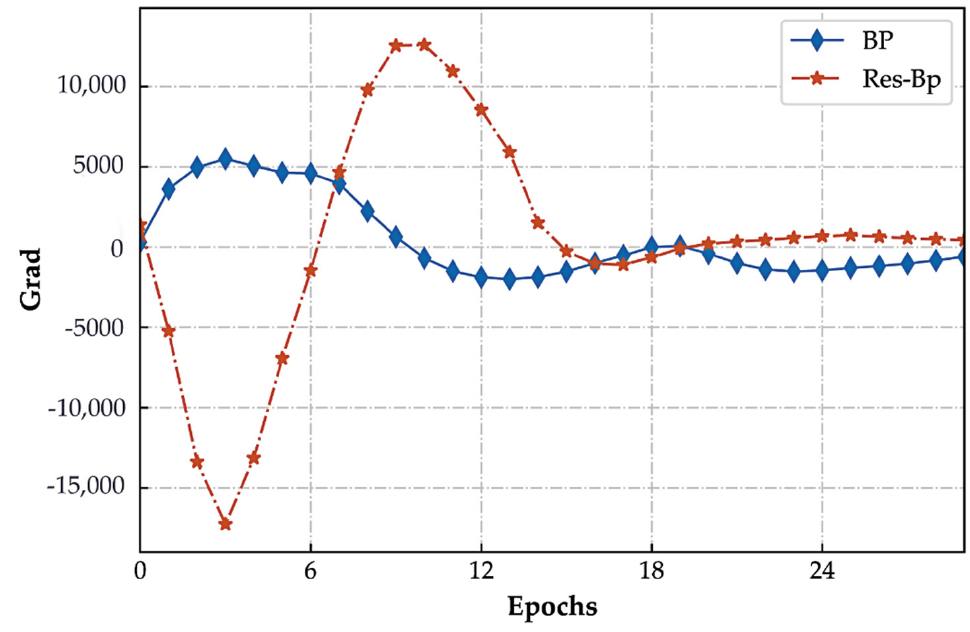
Figure 9. The gradient value of the same parameter during Res-Bp and BP training.